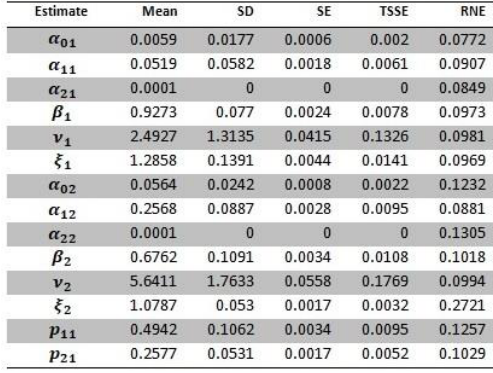
Table 6: Estimates for the 2-State Regime GJR-